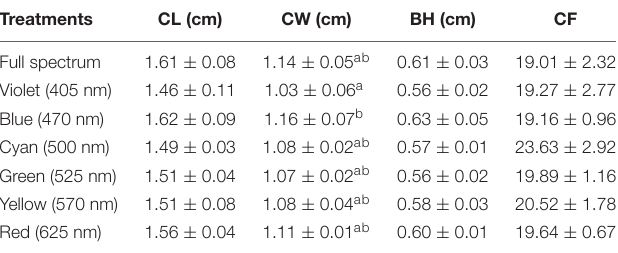
TABLE 2 | Morphology indexes of S. paramamosain reared under different light spectra during 8 weeks, including final carapace length (CL) and width (CW), body height (BH), and condition factor (CF).